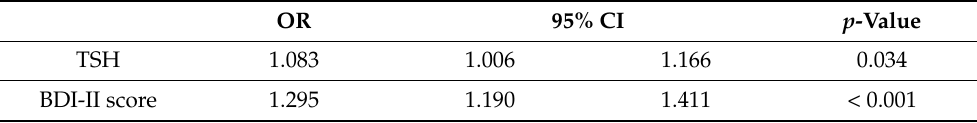
Table 9. Logistic regression for the determining risk factors.